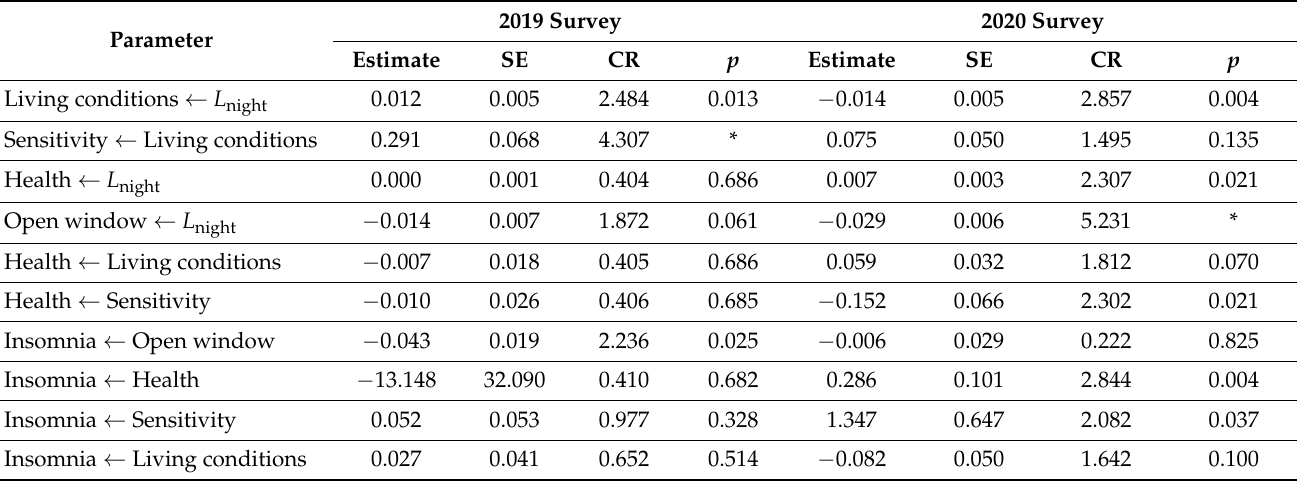
Table 13. Parameter estimates of the structural equation model for insomnia with the opening of the bedroom window during the dry season.